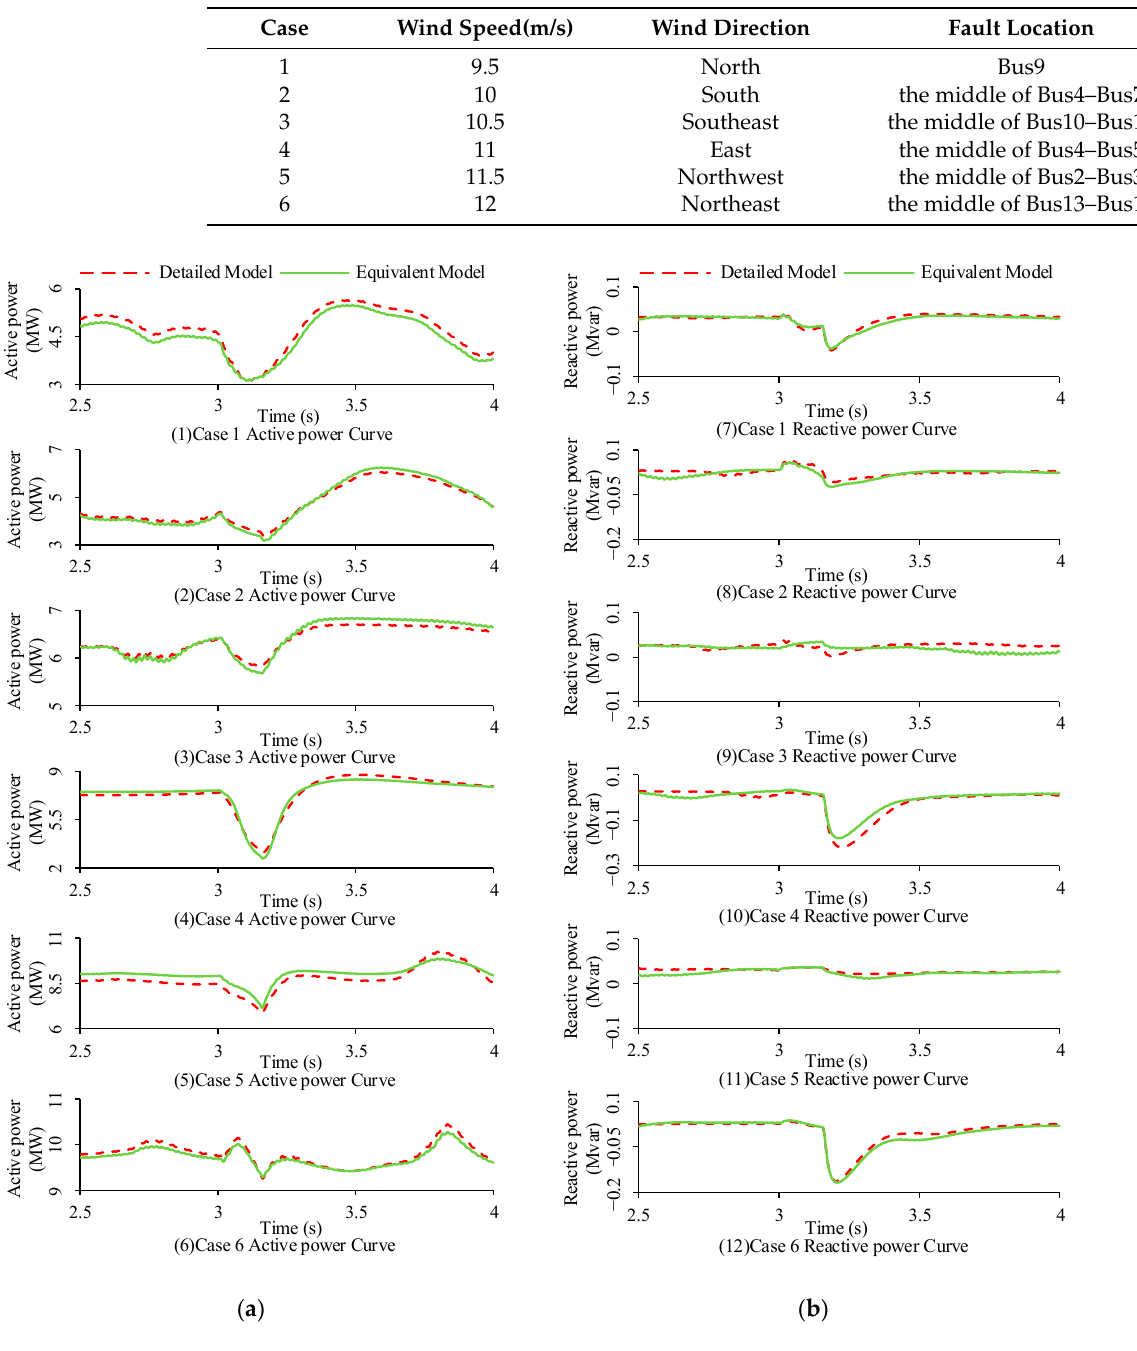
Figure 9. ( a ) Active power curves in PCC of different models. ( b ) Reactive power curves in PCC of different